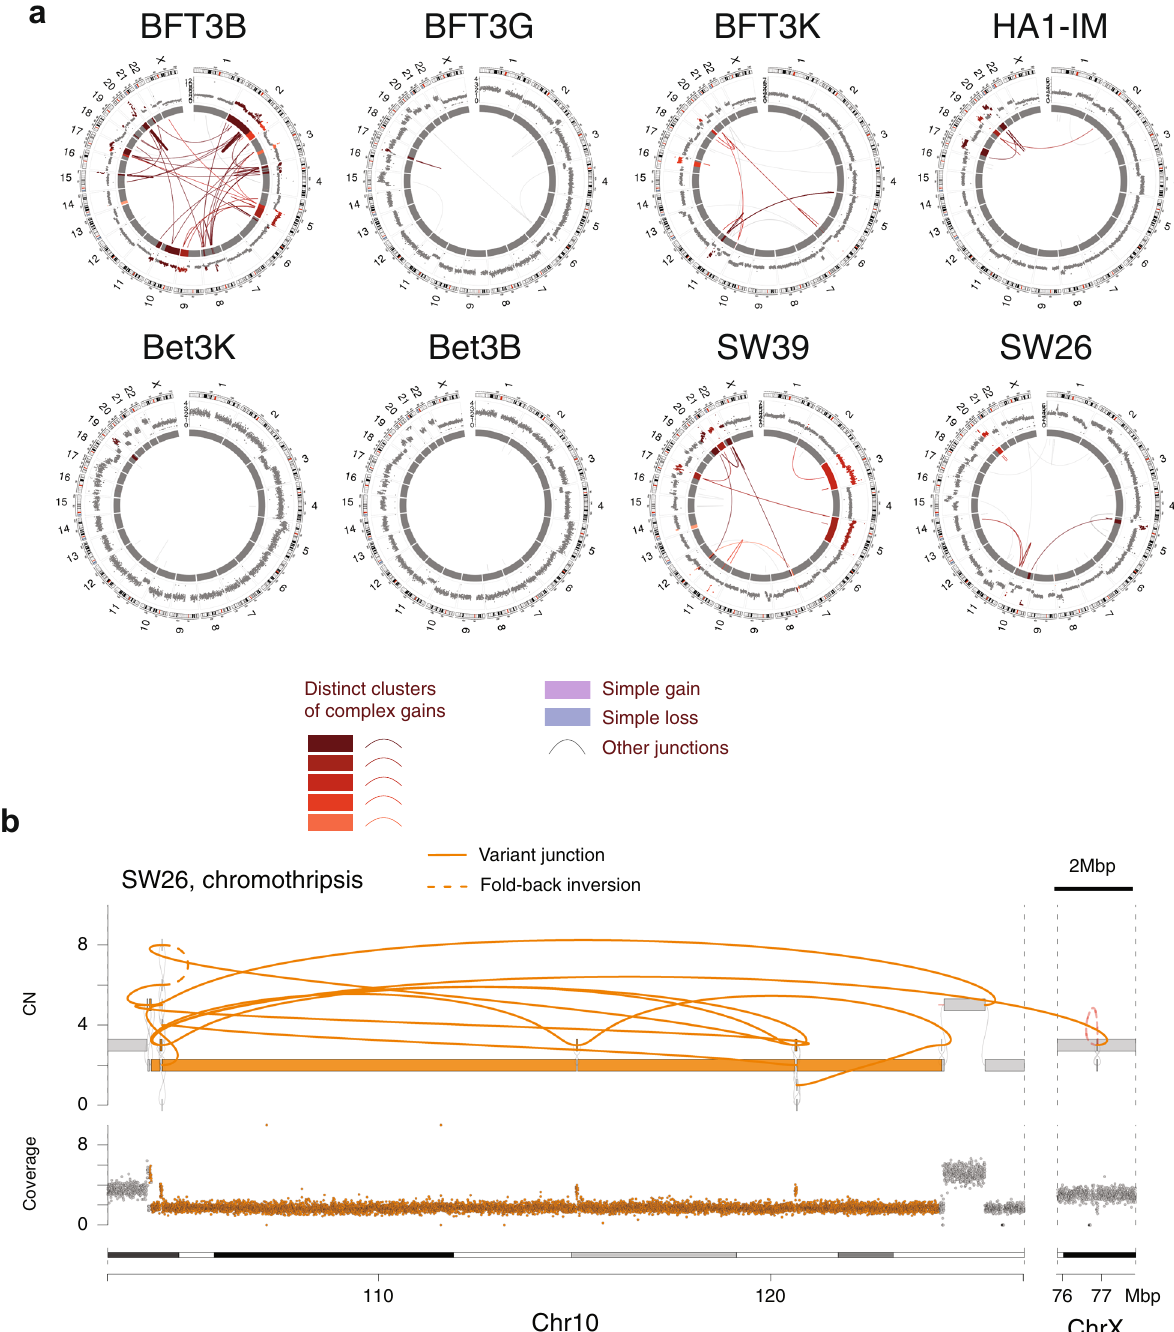
Fig. 1 Genomic complexity after spontaneous telomerase activation. a CIRCOS plots showing eight cell lines that emerged spontaneously from telomere crisis (Supplementary Table 1), fi ve of which show one or more clusters of complex gains. Binned purity- and ploidy-transformed read depth is shown in the periphery, with colored links in the center representing variant (rearrangement) junctions. A series of red colors is used to show junctions and read-depth bins belonging to distinct clusters of complex gains in each cell line. Additional colors describe junctions and bins, including those belonging to simple losses and gains (see “ Methods ” for details regarding junction and bin classi fi cations). b A chromothripsis event in SW26. From bottom to top, chromosomal bands, purity – ploidy-transformed binned coverage data, JaBbA reconstructed copy number with gray and colored edges indicating variant junctions. Dashed colored edges represent fold-back inversion (Supplementary Fig. 1D). The majority of copy changes in these 10 Mbp region of 20q of post-crisis cell line BFT3B that is subgraphs could not be attributed to fold-back inversion ampli fi ed to 10 – 15 copies, incorporating Mbp scale fragments junctions (a hallmark of BFB cycles) but were instead driven by from 11 other chromosomes at lower copy number, including a spectrum of duplication and translocation-like junctions and chromosomes 8 and 19 (Supplementary Fig. 1E). Of note, fi ve of templated insertion chains. These patterns are exempli fi ed in a eight cell lines showed modest increases in TERT copy number,